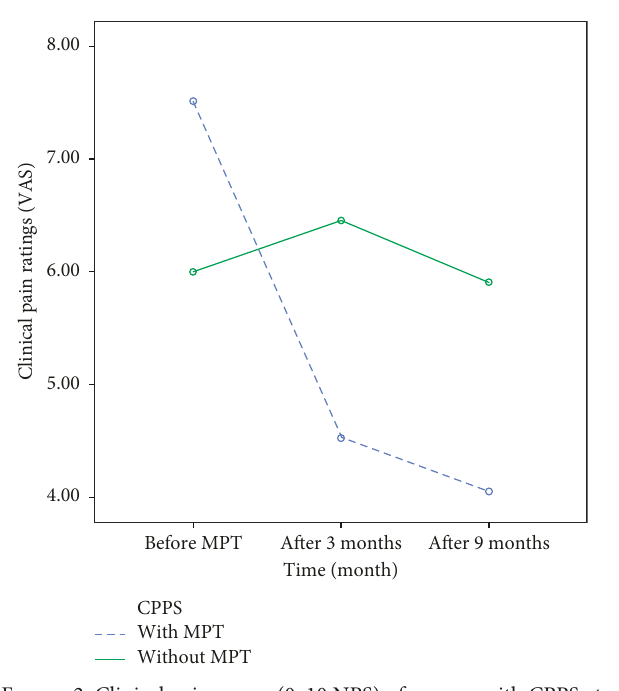
Figure 2: Clinical pain scores (0–10 NPS) of women with CPPS at baseline and following MPTcompared with CPPS women who did not undergo MPT; ∗∗ p < 0 . 01, ∗∗∗ p < 0 . 001. There was a significant improvement in clinical pain ratings among women receiving MPT as assessed before the treatment ( t � 3.18, p � 0 . 003) and at 3 ( t � 3.97, p � 0 . 000) and 9 months ( t � 3.58 p � 0 . 000) compared with the nontreated group. Baseline differences in clinical pain were